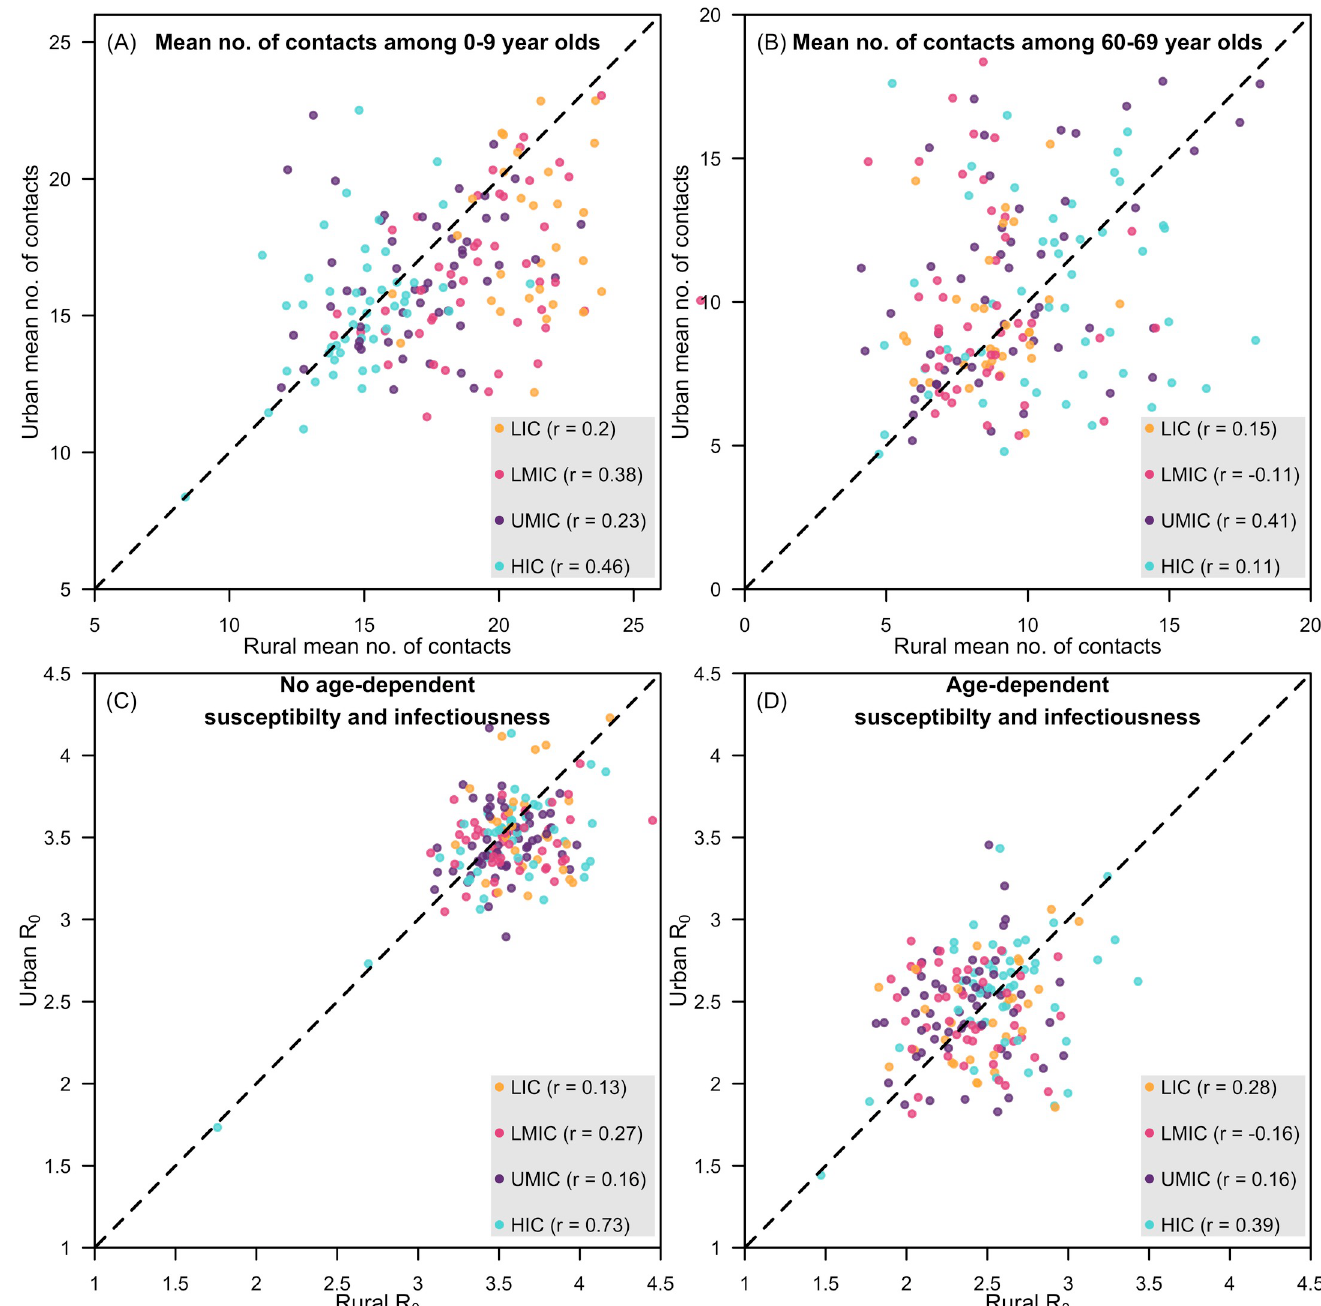
Fig 4. Mean number of contacts and basic reproduction number between rural and urban settings. Panels a and b present the scatter plots of the mean number of contacts in younger and older individuals, respectively, in rural (x-axis) and urban (y-axis) settings of a country. Panels c and d present the scatter plots of the basic reproduction number in rural (x-axis) and urban (y-axis) settings of a country without and with age-dependent susceptibility and infectiousness. Geographical regions are grouped as low-income countries (LIC), lower-middle-income countries (LMIC), upper-middle-income countries (UMIC), and high-income countries (HIC), as designated by the World Bank in 2019. Within income group correlations of rural and urban values are presented in the accompanying parentheses.